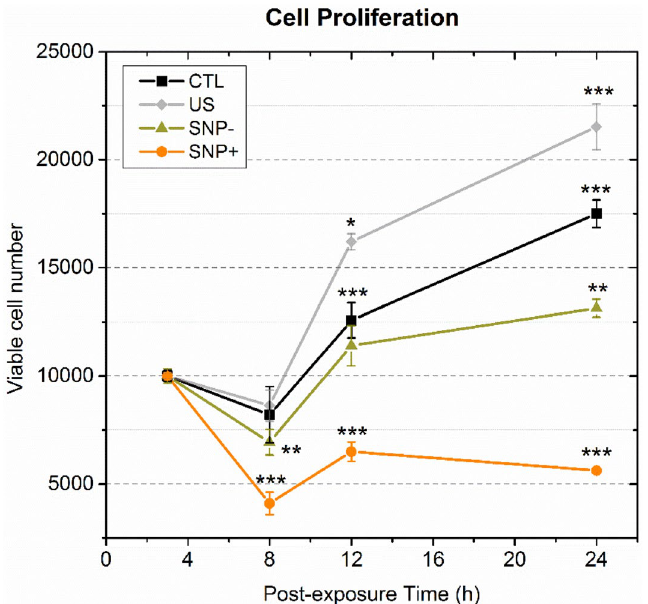
Figure 3. Growth curves of four sorted cell groups (SNP+, SNP–, US, CTL) over 24 h after exposure. Each line plots the total number of viable cells in a sorted cell group at 3 h, 8 h, 12 h, and 24 h after exposure. to evaluate Cell count was normalized to 10 4 cells at the initial time point. Each data point, acquired from three experiments ( N =3) with 3 to 5 population samples each, was presented as mean ± standard deviation (*, **, and *** respectively denote p < 0.05, p < 0.01, p < 0.001 versus the 3 h time point of the same